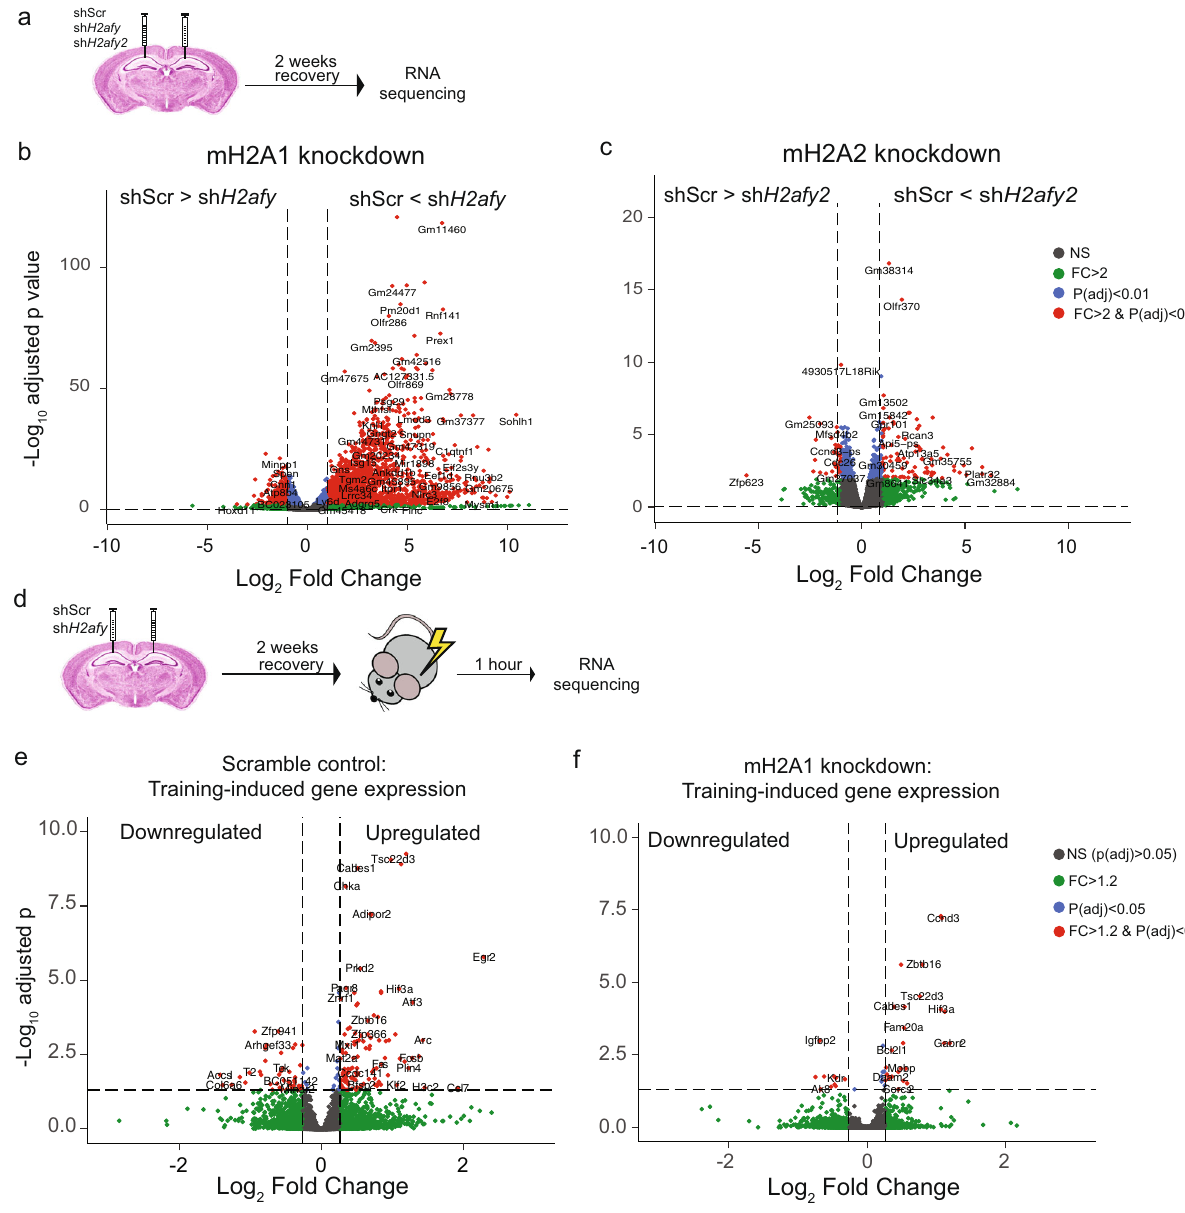
Fig. 2 mH2A1 depletion promotes basal gene expression and blocks learning-induced gene induction. a Experimental design. Mice underwent stereotaxic surgery for intra-hippocampal (CA1) injections of AAV-DJ vectors carrying shRNA constructs against a scramble control sequence, H2afy or H2afy2 . After 2 weeks of recovery, the infected region was extracted and RNA was sequenced. b Intra-CA1 depletion of H2afy (encodes mH2A1) alters the hippocampal expression of 2350 genes, majority of which (85%) were upregulated (signi fi cance cut-off: p adj < 0.01 and FC > 2). c Intra-CA1 depletion of H2afy2 (encodes mH2A2) alters the expression of 127 genes, 69% of which were upregulated (signi fi cance cut-off: p adj < 0.01 and FC > 2). d Experimental design for testing the effects of mH2A1 depletion on training-induced gene expression. Mice underwent stereotaxic surgery for intra-CA1 injections of shScr or sh H2afy and were given 2 weeks to recover. After 2 weeks, half of the mice were fear conditioned and half were left undisturbed in their home cage. RNA was extracted from infected tissue and gene expression was compared in trained vs untrained mice for each virus. e In area CA1 of the hippocampus of scramble control mice, fear conditioning altered the expression of 169 genes, 122 of which were upregulated (signi fi cance cut-off: p adj < 0.05 and FC > 1.2). f In area CA1 of the hippocampus of mH2A1-depleted mice, fear conditioning altered the expression of 44 genes, 33 of which were upregulated (signi fi cance cut-off: p adj < 0.05 and FC > 1.2). n = 3